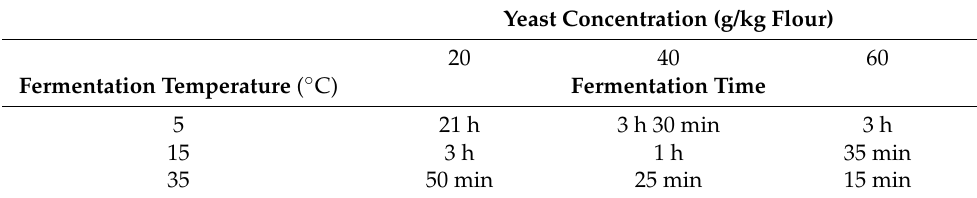
Table 4. Parameters of the fermentation process.